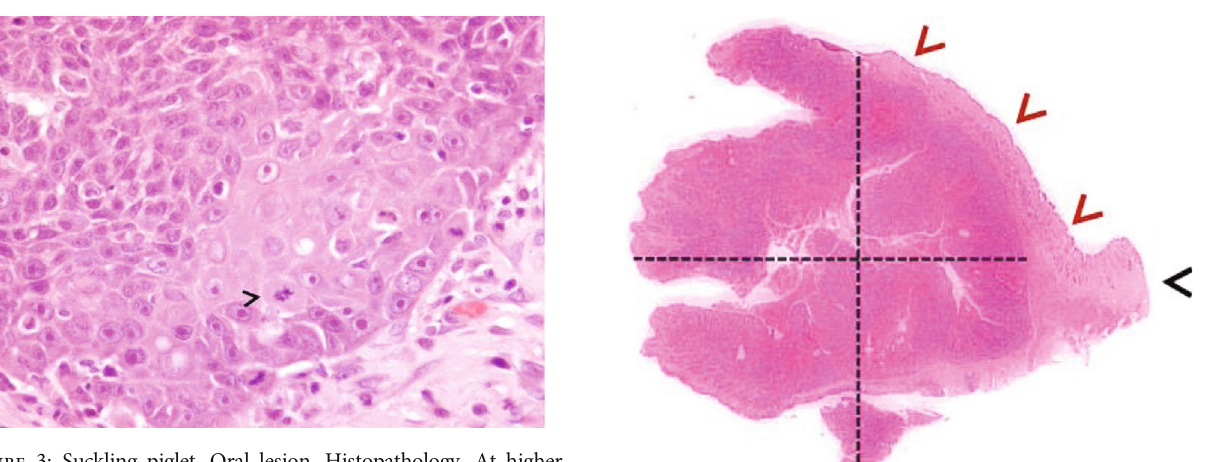
Figure 3: Suckling piglet. Oral lesion. Histopathology. At higher magni fi cation, intercellular bridges can be easily appreciated (black arrowhead). Mitoses are also evident. H&E, original objective 40x.